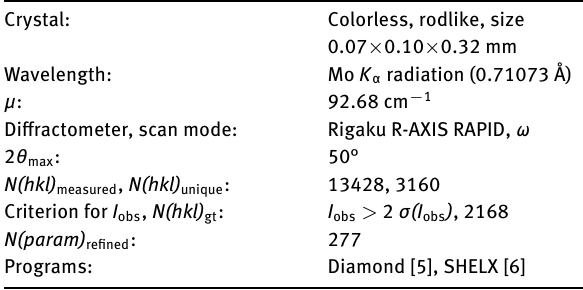
Table 2: Fractional atomic coordinates and isotropic or equivalent isotropic displacement parameters (Å 2